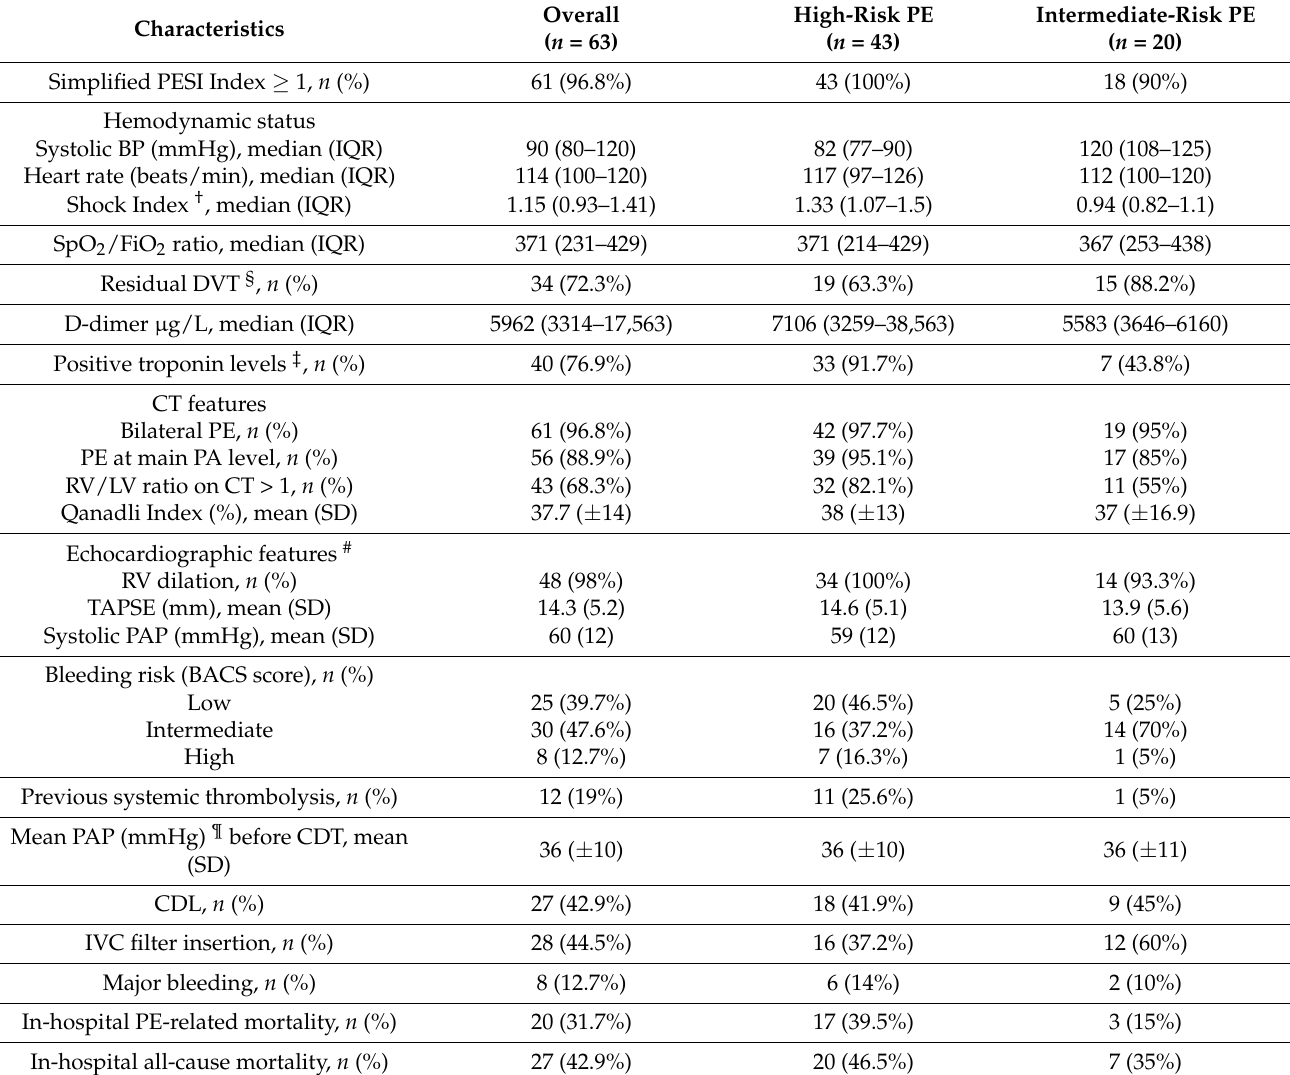
Table 2. Pulmonary embolism characteristics, treatment and in-hospital